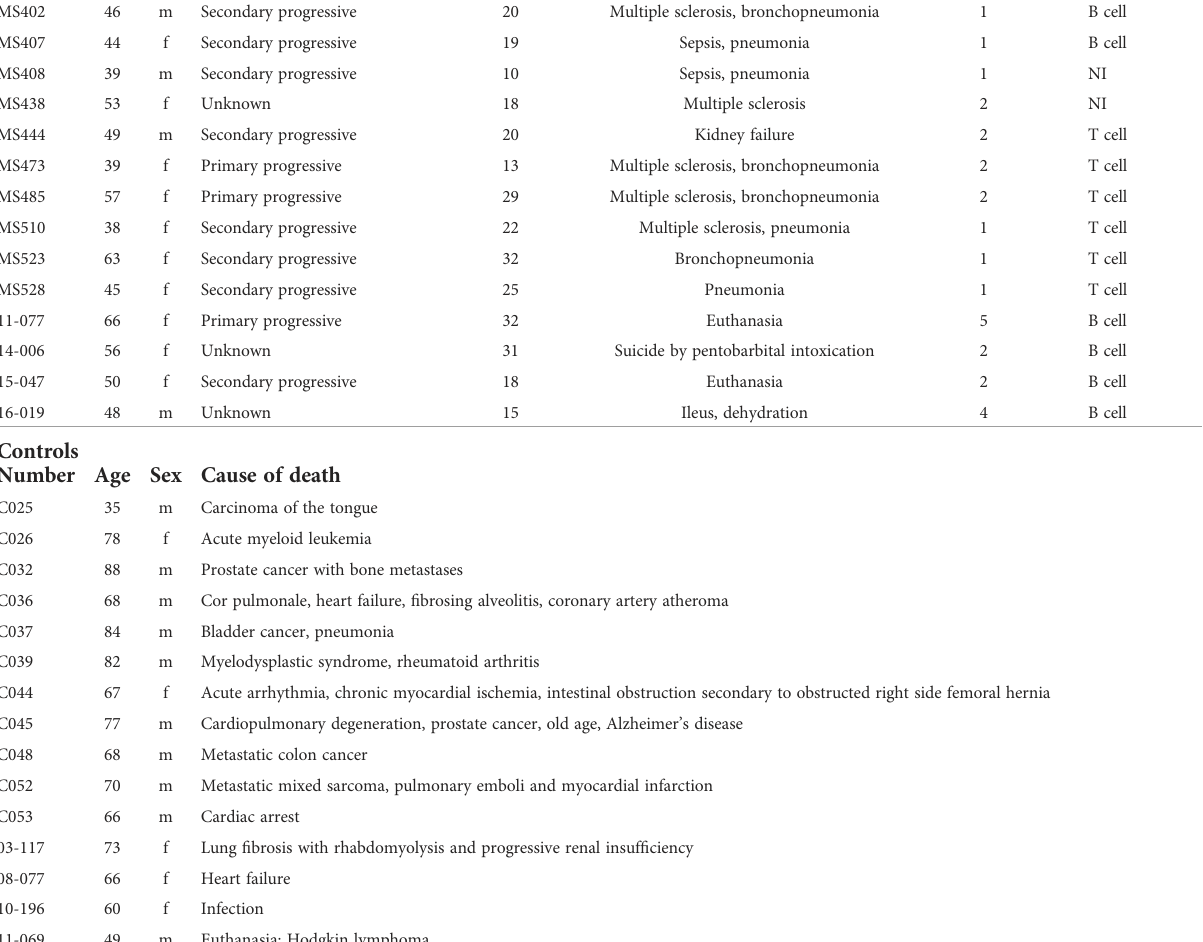
Lung fi brosis with rhabdomyolysis and progressive renal insuf fi ciency